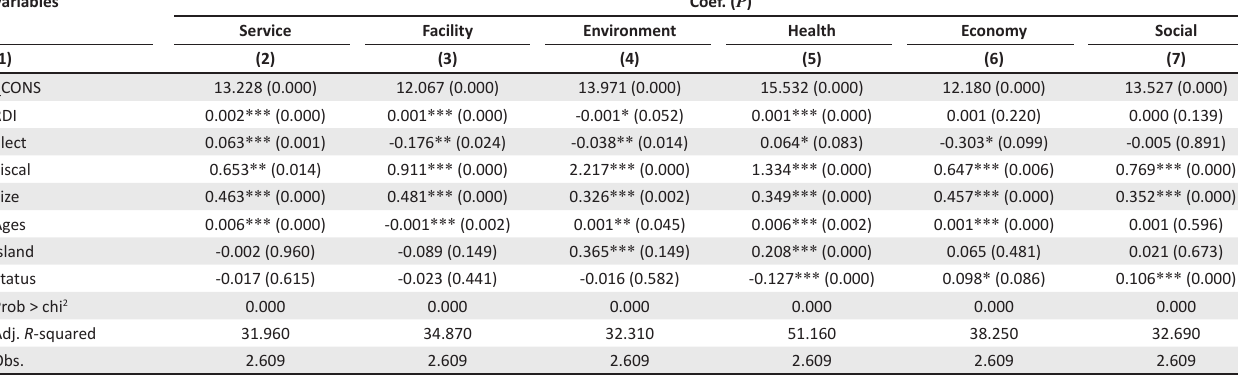
TABLE 5: The effect of the Disaster Risk Index on public service functions of local governments. Variables Coef. ( P